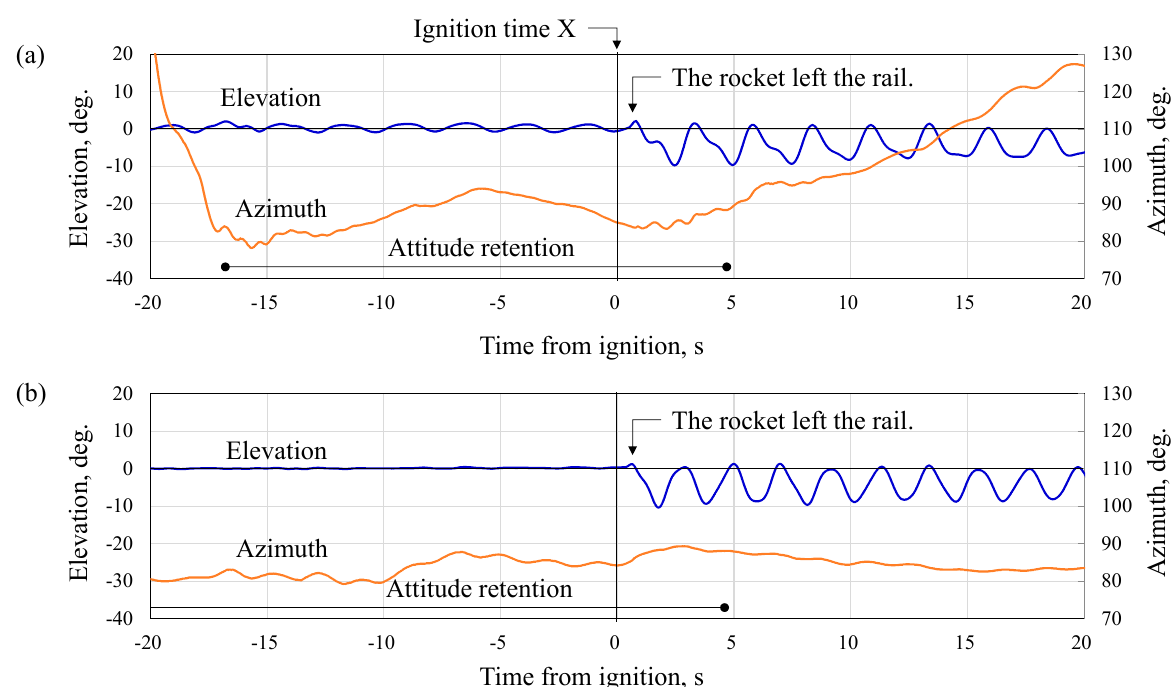
Figure 4. Launcher attitude with respect to time. ( a ) First launch ( b ) Second launch. The elevation angle oscillated with a peak-to-peak amplitude of 2° about the equi- librium until ignition. After ignition, the equilibrium elevation angle decreased by 4.4° and a non-sinusoidal oscillation with a peak-to-peak amplitude of 10° was excited with respect to the new equilibrium elevation angle. This type of behavior is characteristic of suspended launchers. The decrease in the equilibrium angle was in good agreement with an angle of 5.4° , which was predicted based on the movement of the CG of the launcher assembly after the removal of the rocket. The largest elevation was observed at X + 0.8 s after the ignition; this was due to an upward moment owing to the friction force on the rail and the thrust misalignment force. This effect increased the actual elevation angle by 0.8°. Approximately the same increase in the elevation angle was observed in the other launches.